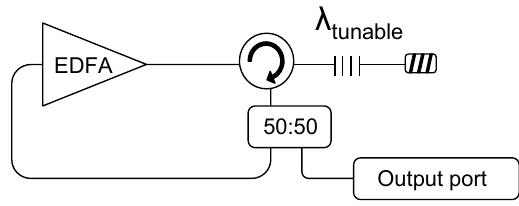
Figure 2. Basic design of the tunable